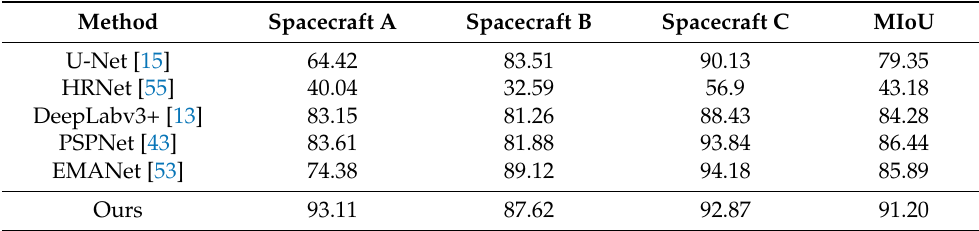
Table 4. The MIoU results of network comparative experiments on the test set.